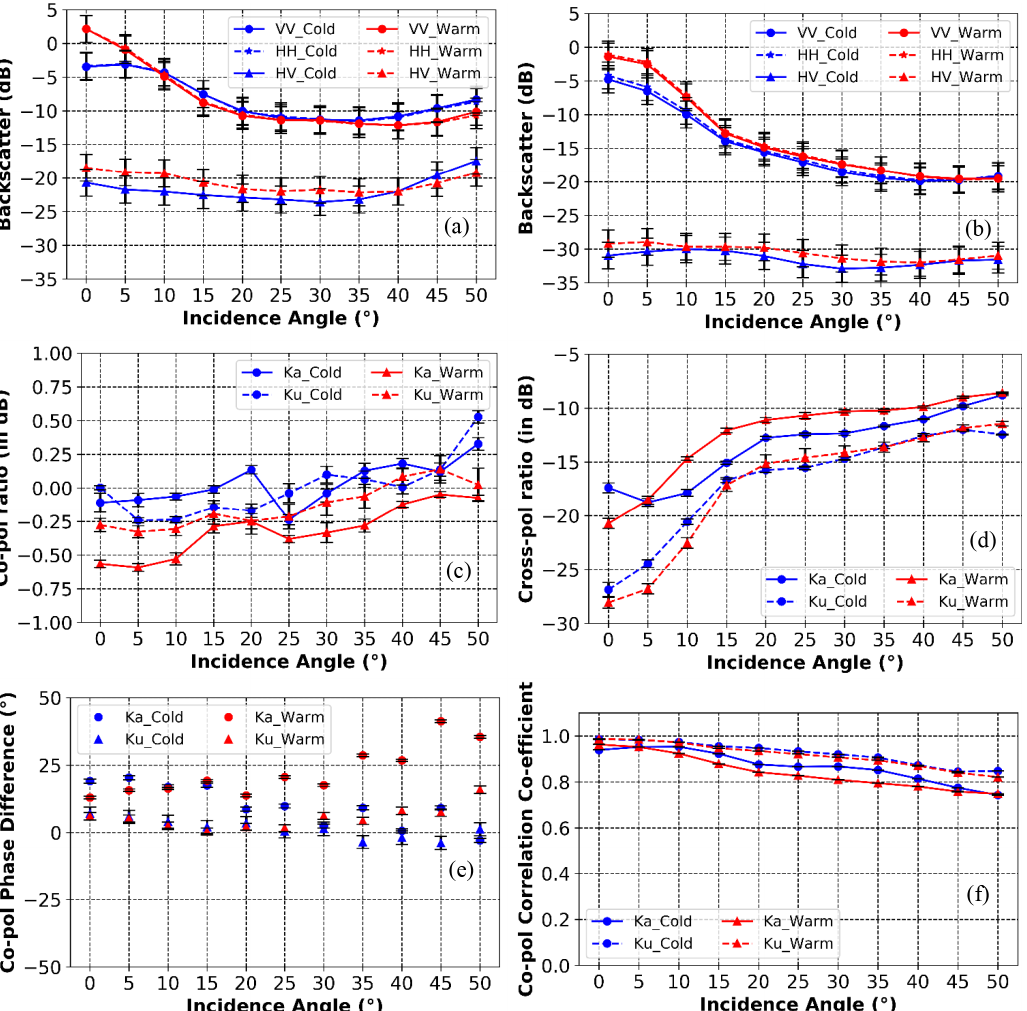
Figure 11. Ku- and Ka-band polarimetric backscatter and parameters from snow-covered sea ice from the RS site acquired on 10 November (cold) and 15 November (warm) 2019. (a) Ka-band co- and cross-polarized backscatter σ 0 polarized backscatter σ 0 , σ 0 and σ 0 ; (c) copolarized ratio γ CO ; (d) cross-polarized ratio γ CROSS ; (e) copolarized phase difference VV HH HV ϕ VVHH ; and (f) copolarized correlation coefficient ρ VVHH . Fit lines are cubic for backscatter, and error bars represents standard deviation. Fit lines for copolarized ratio, cross-polarized ratio and copolarized correlation coefficient are quadratic. Errors bars for these parameters represent standard deviation (copolarized and cross-polarized ratio) and min–max (copolarized correlation coefficient). Error bars for copo- larized phase difference represent standard